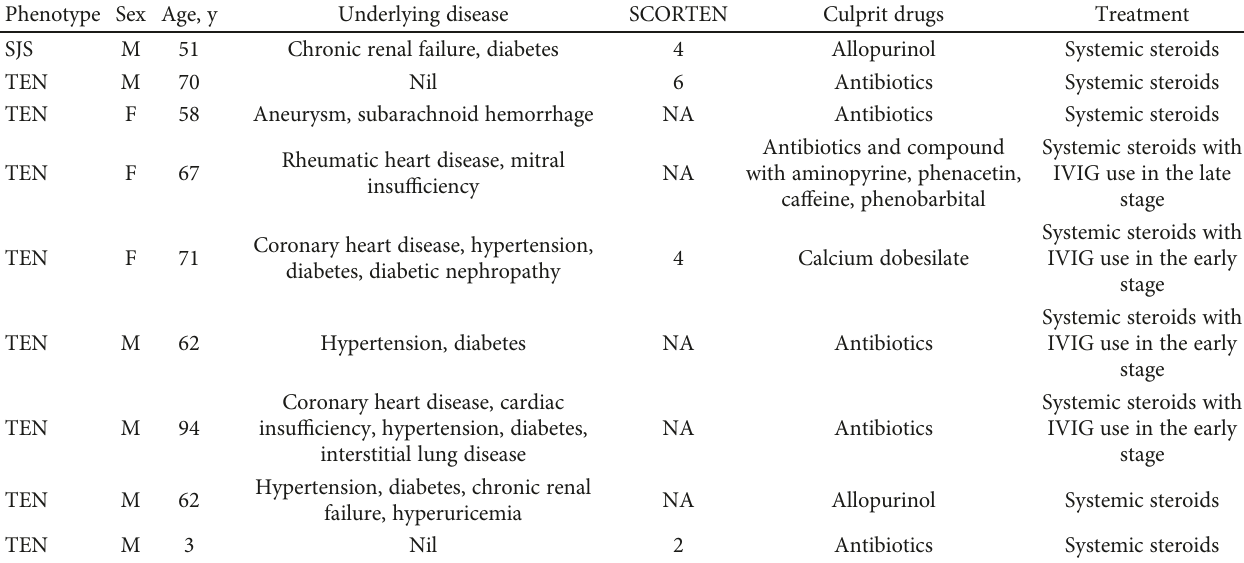
Table 5: Information of the deceased patients with SJS/TEN in this study ( n =XXX).